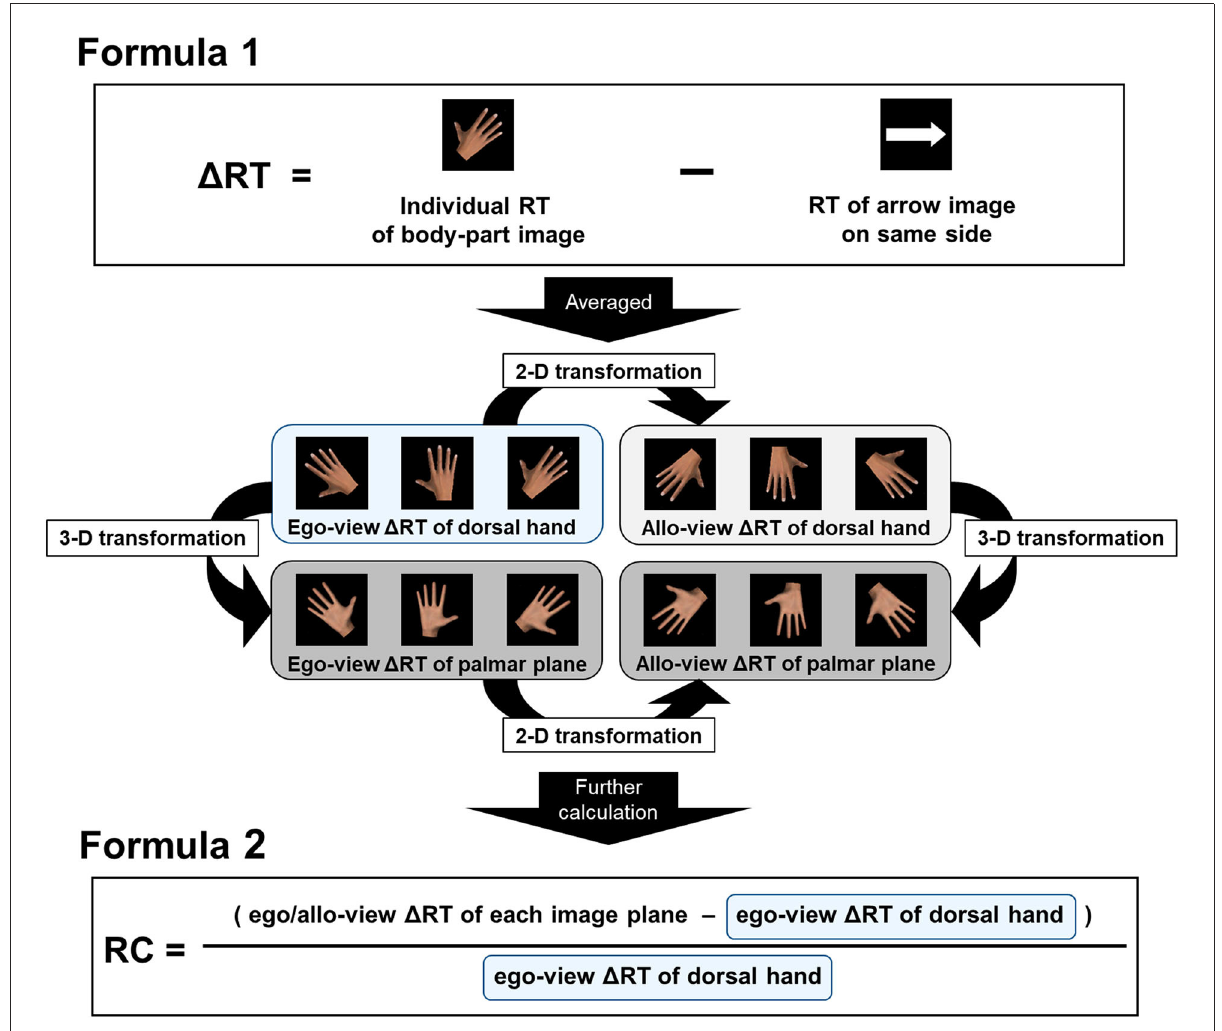
FIGURE3 Illustration of data handling. Herein, right-hand image is shown as an example. RT of the arrow image (arrow RT) on the same side was subtracted from individual raw RT data for the body part images ( 1 RT; Formula 1). Averaged RTs for egocentric views (ego-view 1 RT; 0 ◦ , 45 ◦ , and 315 ◦ ) and allocentric views (allo-view 1 RT; 135 ◦ , 180 ◦ , and 225 ◦ ) were then individually calculated. As shown in the center of the figure, the two-dimensional (2-D) or three-dimensional (3-D) transformation process in the MR task was assumed in reference to the ego-view 1 RT of the dorsal side body part images (reference value). The rate of change (RC) was calculated by subtracting the reference value from the ego/allo-view 1 RT of each image plane and dividing the value by the reference one (Formula 2) and used as an indicator of the transformation